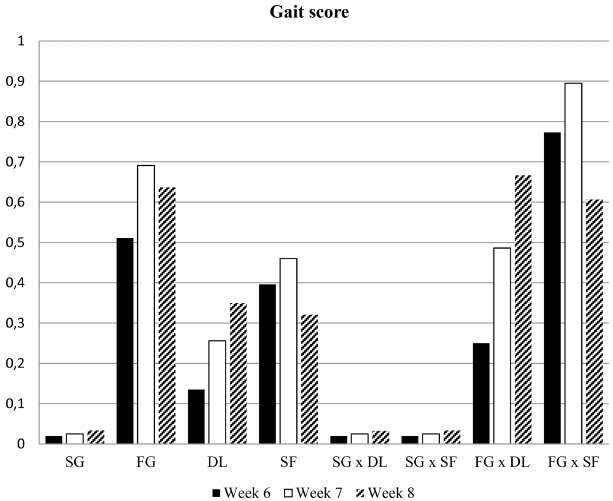
Figure 4. Mean values of gait scores of all groups. SG: slow grow- ing, FG: fast growing, DL: deep litter, SF: slatted floor.